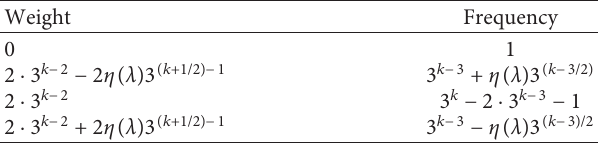
S 0 for Theorem 2 (ii).